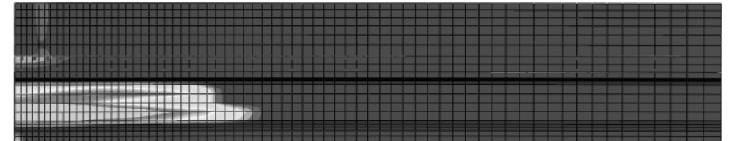
Fig. 21. Maximum principal plastic strain, blast above, between girders. Side view of interior girder.